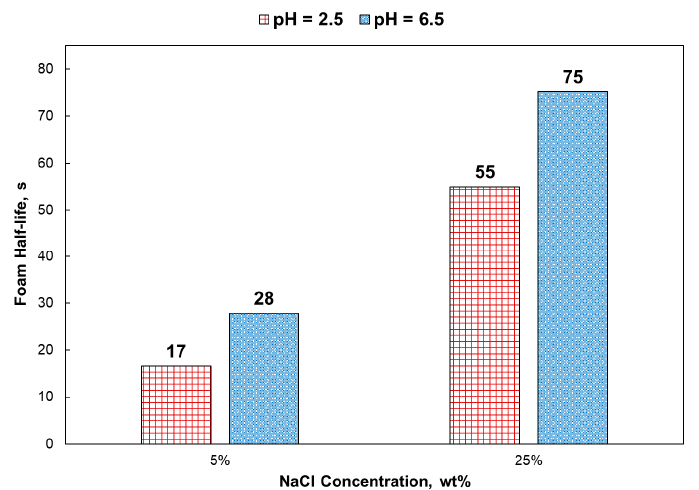
Figure 11. Effect of salinity on the foam stability at 150 °F (65 °C) and 500 psi (34.5